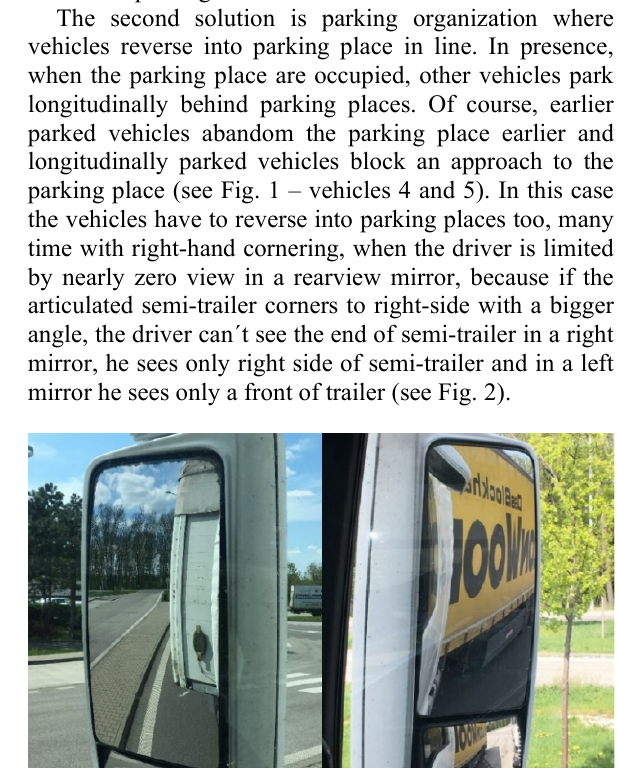
The proposal is processed that vehicles reverse into parking places always with left-handed cornering, when although the driver after cornering of road train has a limited view in right rearview mirror where he sees only front of trailer, but he sees the left side of road train also in mirror and after cornering he sees the whole of semi-trailer from a side driver´s window with a bigger angle. Reversing to the left side is more comfortable and safe for the driver. This solution of car park is more economical for built-up area where is eliminated a demand on road behind first park line, also between second and third park line. A fourth park line is visible only from the reason of showing of blocking by longitudinal parking. The first parking line is proposed according to demand of drivers in transport survey that vehicles are arranged to stay with driver´s cab away from the highway, for lower noise and higher rest comfort of driver. However, turning the driver's cab only does not sufficiently eliminate noise, mainly in empty car park, so it is necessary to build a noise barrier behind the first